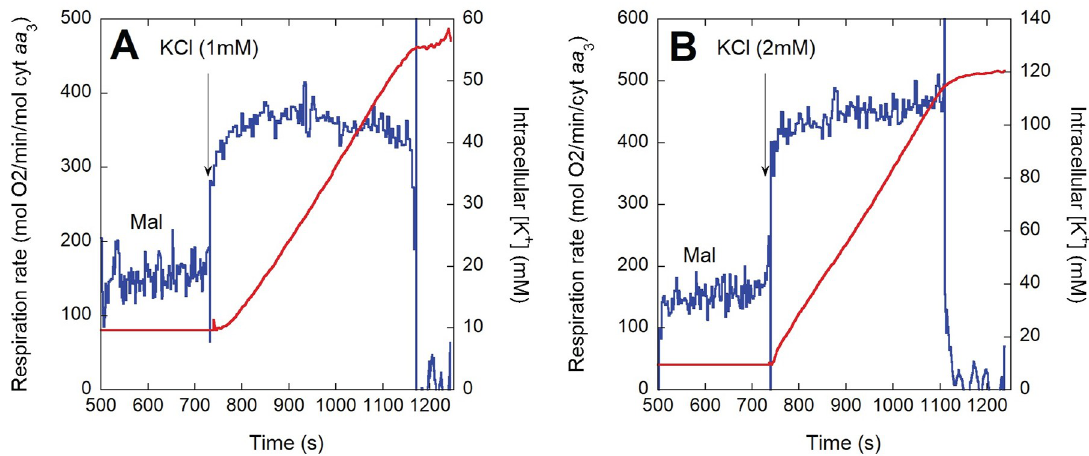
Fig 3. Respiration rate (blue) and intracellular [K + ] (red) before and after addition of 1 mM (A) or 2 mM (B) KCl to CyoB - /CcoN - cells grown in malate. Thawed cells (~2 x 10 9 /ml) were incubated in depletion NH 4+ -free buffer to which 16.5 mM sodium malate (Mal) was added at ~500 s followed by KCl at the time point indicated by the arrow in each panel.